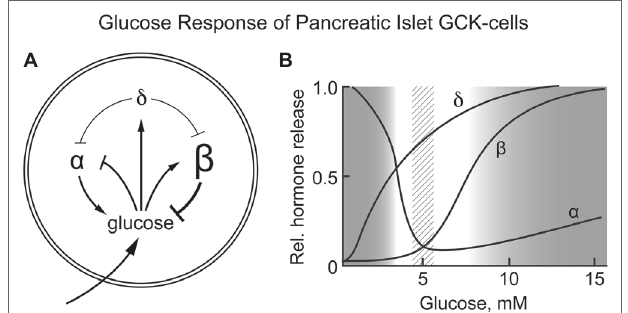
FIGURE 2 | (A,B) Response of pancreatic α , β , and δ -cells to systemic glucose concentration and the relationship of hormone release by each cell type as a function of blood glucose levels. Schematically represents the role of each cell type in controlling blood glucose concentration. Increasing glucose suppresses glucagon release by α -cells while increasing insulin release by β -cells. It also increases release of somatostatin from δ -cells, a paracrine signal that suppresses hormone release by both α - and β -cells. (B) schematically shows the relative amount of hormone released at each glucose concentration. A dotted vertical bar is shown at 5 ± 0.5 mM, the set point for glucose homeostasis. (B) is based on graphic depictions (Matschinsky et al., 1976; Gylfe, 2016; Rorsman and Huising,